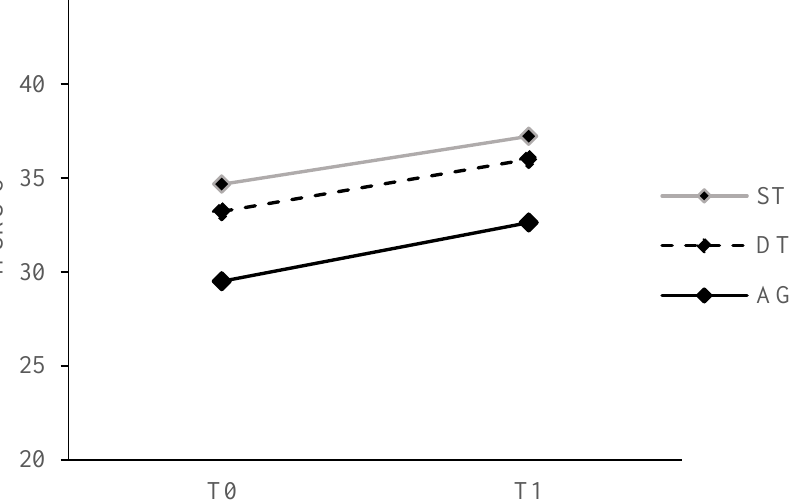
Figure 2. Comparison of movement-specific reinvestment propensity (primary outcome) from T0 to T1 for all training groups. MSRS-C, Chinese version of the Movement Specific Reinvestment Scale; ST, single-task training group; DT, dual-task training group; AG, analogy training group.